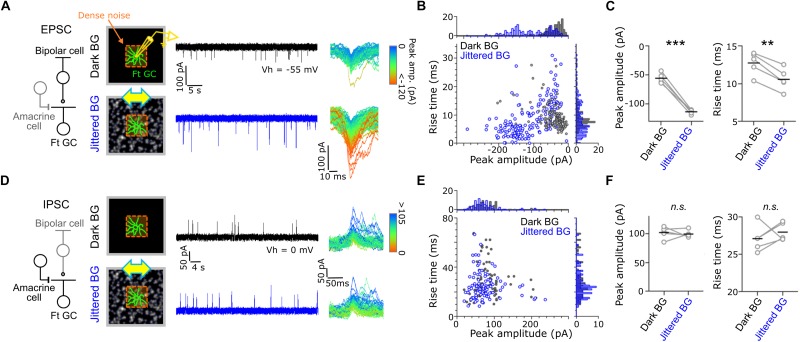
Synaptic inputs to Fast-transient GCs. (A) Excitatory postsynaptic currents (EPSCs) evoked by dense noise stimulation under the Dark (upper, black) and Jittered (lower, blue) BG conditions. Left, a schematic of synaptic inputs to a Ft GC. Middle, a schematic of recordings and evoked EPSCs in a Ft GC voltage-clamped at –55 mV (Vh). Right; superimposed excitatory events, in which each color indicates different peak amplitude. (B) Plot of peak amplitude and rise time for each excitatory event under the Dark (gray dots) and Jittered (blue dots) BG conditions. Data from the Ft GC shown in panel (A). (C) Mean peak amplitude (left) and rise time (right) in individual cells (circle) under the Dark and Jittered BG conditions. Black line, mean. 5 Ft GCs. (D–F) Inhibitory postsynaptic currents (IPSCs) recorded from Ft GCs voltage-clamped at 0 mV. 5 Ft GCs. ∗∗p < 0.01; ∗∗∗p < 0.001. See also Supplementary Figure S3.